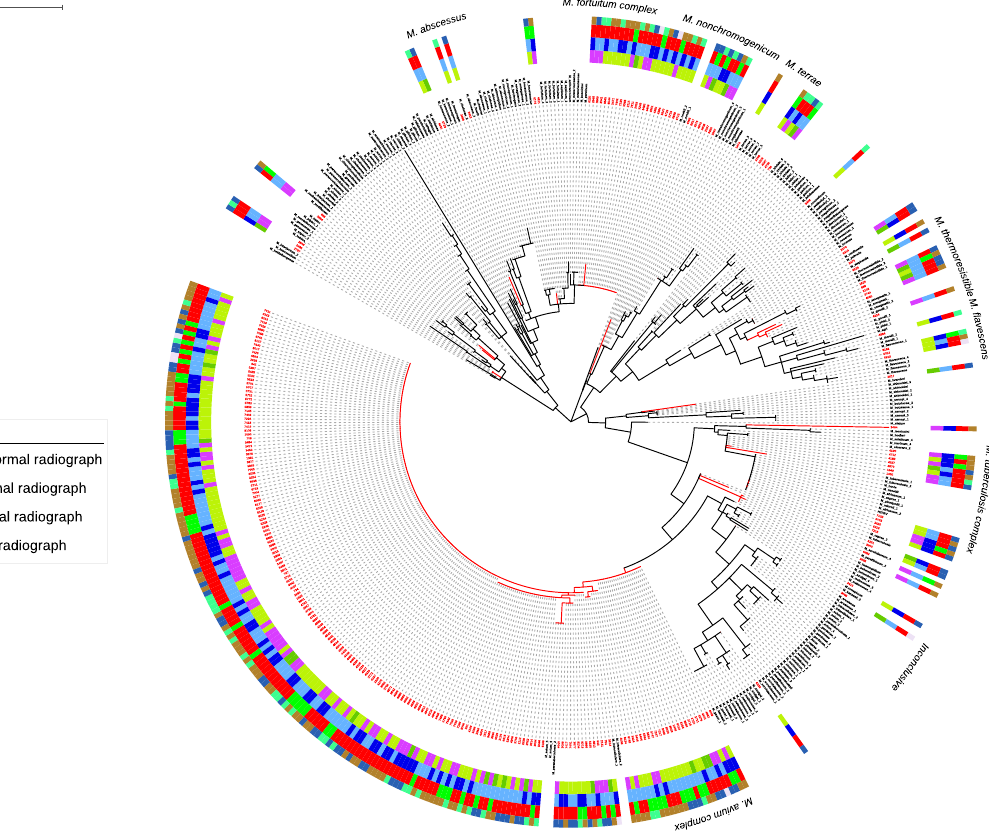
Figure 4. Phylogenetic tree of NTM in The Gambia based on 16S rRNA gene sequence analysis of regions A and B of the mycobacteria gene. Red coloured fonts represent unknown sequences from the present study while fonts in black colour represent NTM and MTBC reference sequences of ATCC strains downloaded from GenBank.